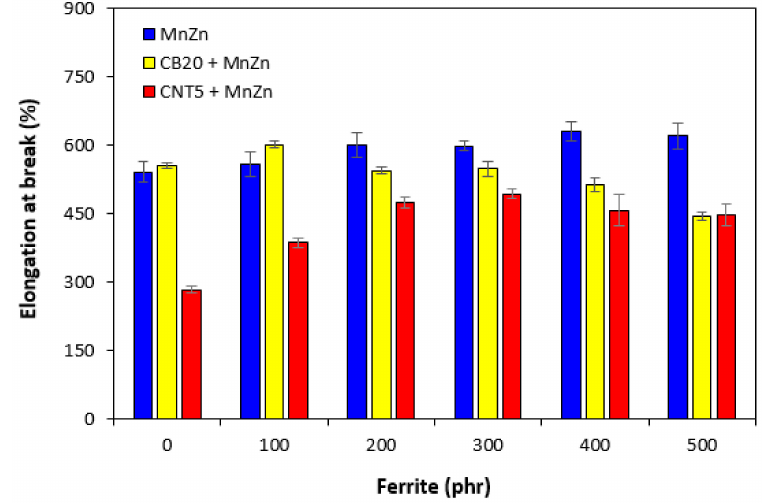
Figure 13. Elongation at break of composites.